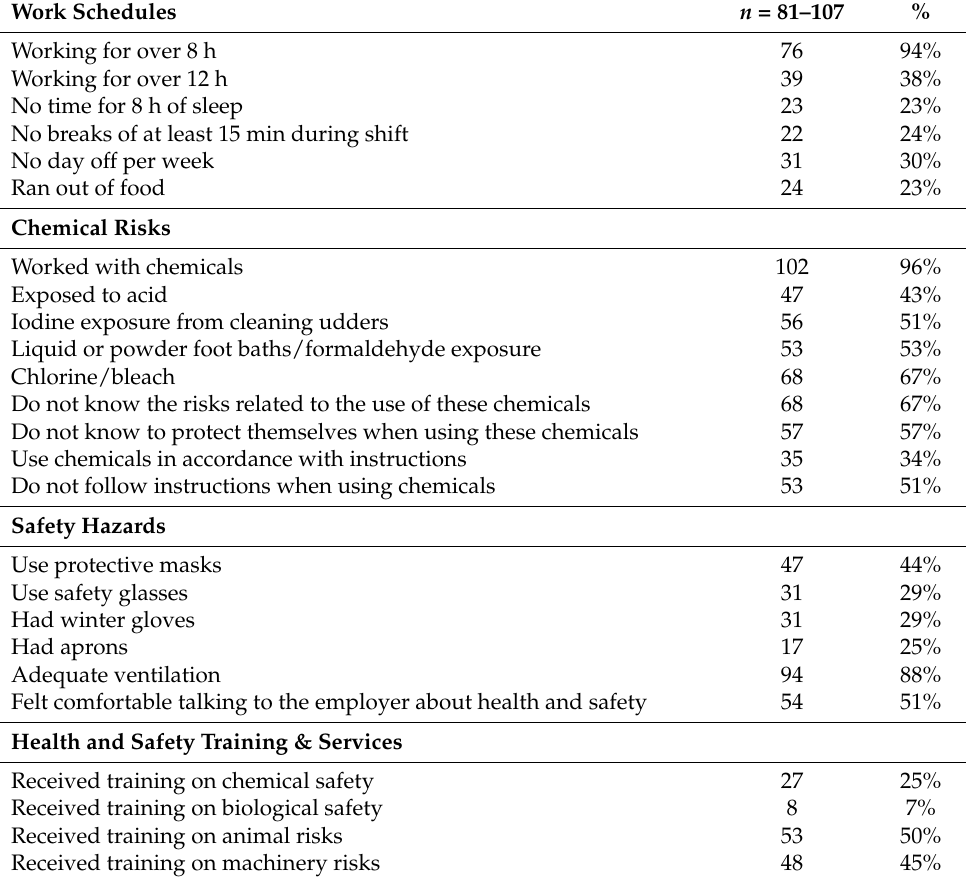
Table 1. 2019 Health and Safety Survey: Working conditions in Vermont dairy